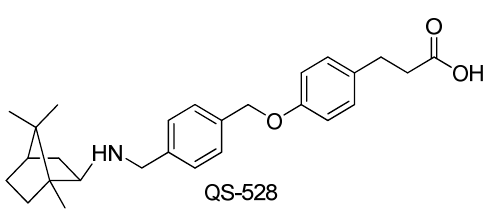
Figure 1. N-alkyl derivative of isobornylamine.